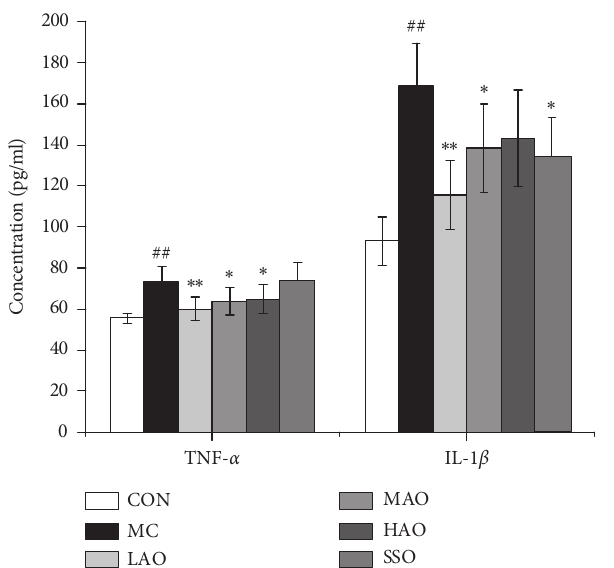
Figure 5: Effects of almond oil on serum ALT and AST in STZ- induced rats. ALT, alanine transaminase; AST, aspartate trans- aminase. Data were expressed as means ± SD. The MC group compared with the CON group, # P < 0 . 05, ## P < 0 . 01; the LAO, MAO, HAO, and SSO groups compared with the MC group, ∗ P < 0 . 05, ∗∗ P < 0 . 01.